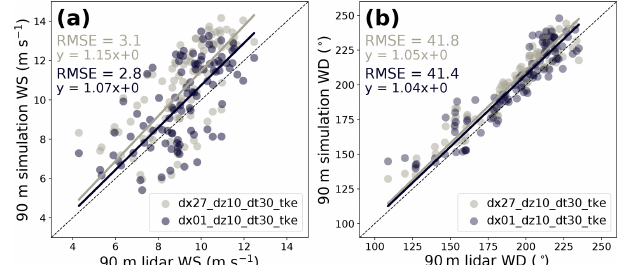
Figure 5. Hourly values of 90m (a) wind speed (WS) and (b) wind direction (WD) from two of the simulations tested plotted against those of the scanning lidar. Dots, lines of best fit, and their corre- sponding equations and RMSE calculations in both panels are col- ored based on the model configuration denoted in the legend. One- to-one lines are dashed in